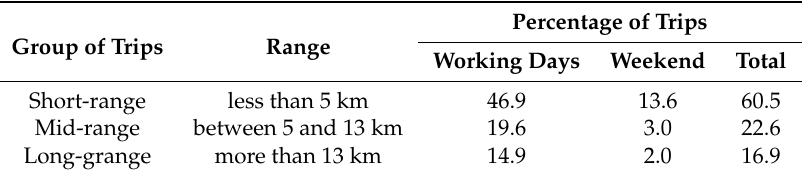
Table 2. Identification of groups based on travelled